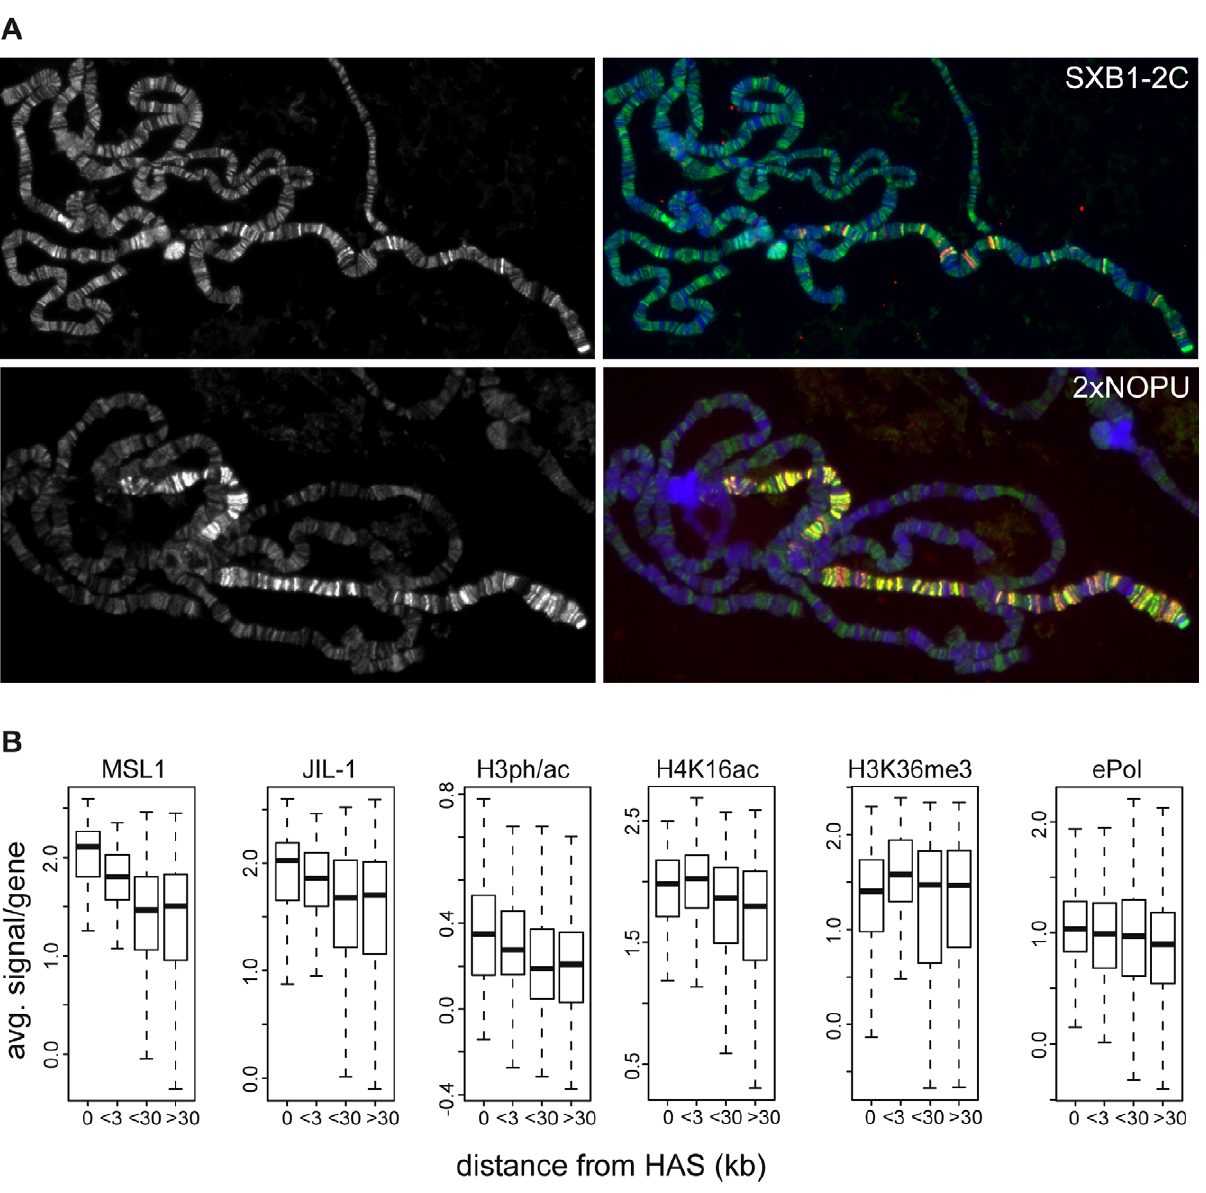
Figure 7. Distribution of JIL-1 on the X-chromosome. (A) Localization of JIL-1 (left panels, green in the merged pictures) in SXB1-2C and 2xNOPU females expressing increasing amounts of MSL2 (coloured red in the merged pictures on the right). (B) Densities of various features on active X-chromosomal genes grouped by increasing distance from high affinity sites (HAS) for the DCC. There are 115, 121, 405 and 465 genes in the group of genes located at increasing distances from HAS,